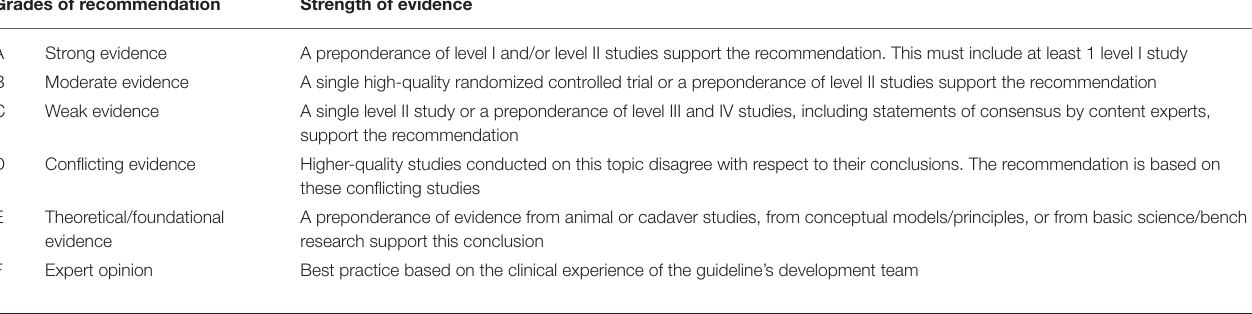
TABLE 2 | Grades of recommendation. Grades of recommendation Strength of evidence